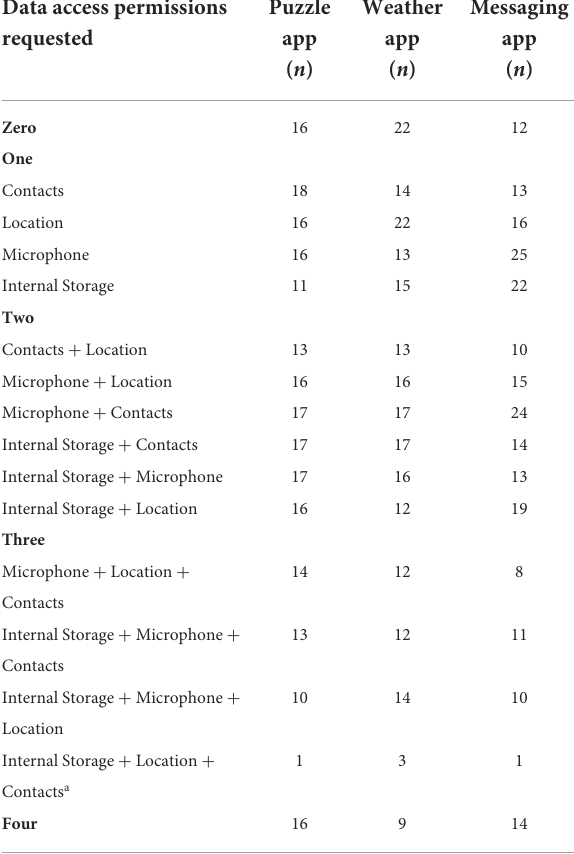
TABLE 1 Number of participants per experimental